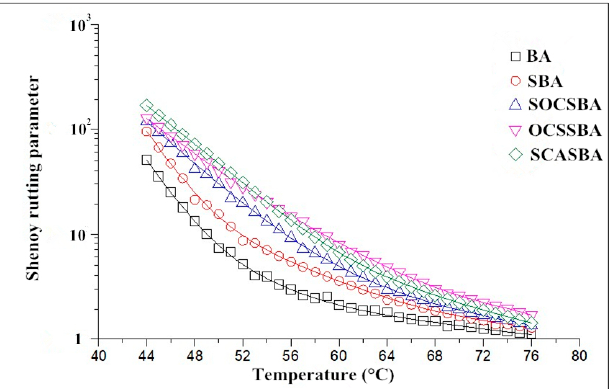
Figure 12. The relationship between Shenoy rutting parameter and temperature for modified and unmodified asphalt.